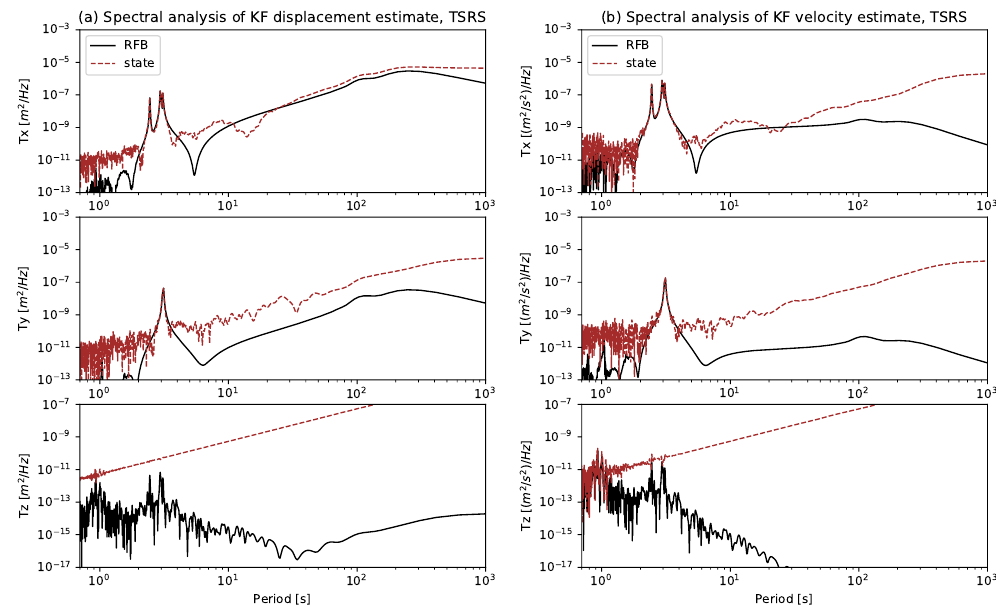
Figure A3. The robot feedback (RFB) is plotted in black and the KF estimate (state) is plotted in brown for the TSRS experiment. The ( a ) shows the KF displacement estimate and ( b ) shows the KF velocity estimate.